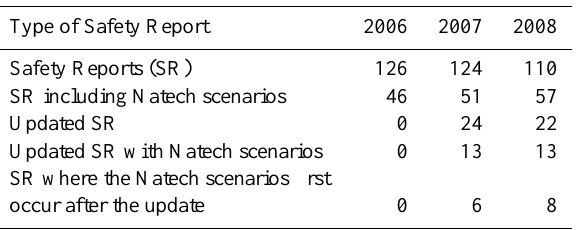
Table 1. The comparative situation of NaTech scenarios considered in Seveso sites risk analysis.